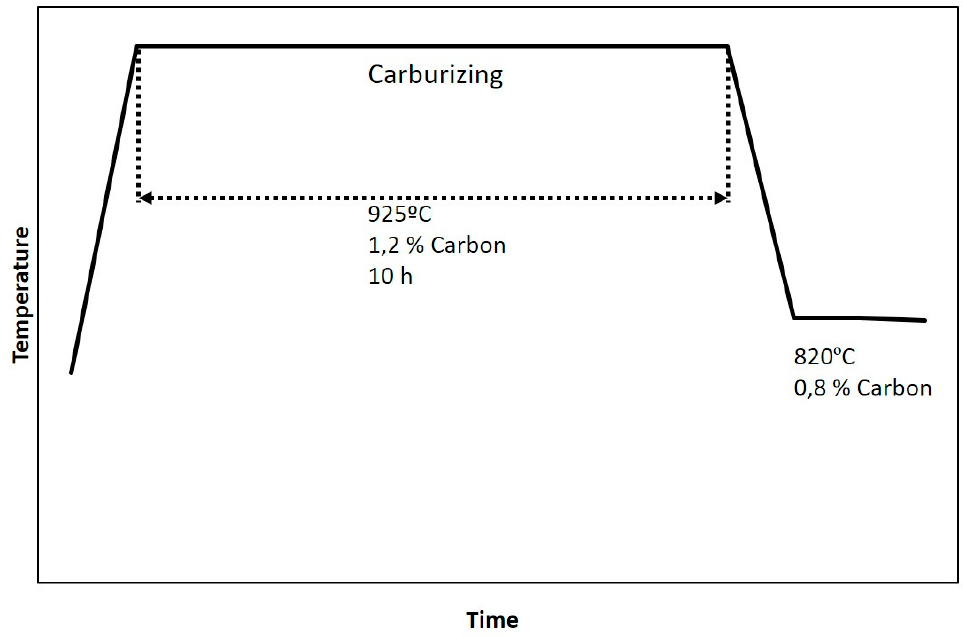
Figure 2. Schematic representation of the carburizing cycle holding at 925 °C for 10 h, quenched to 820 °C, followed by cooling in air.